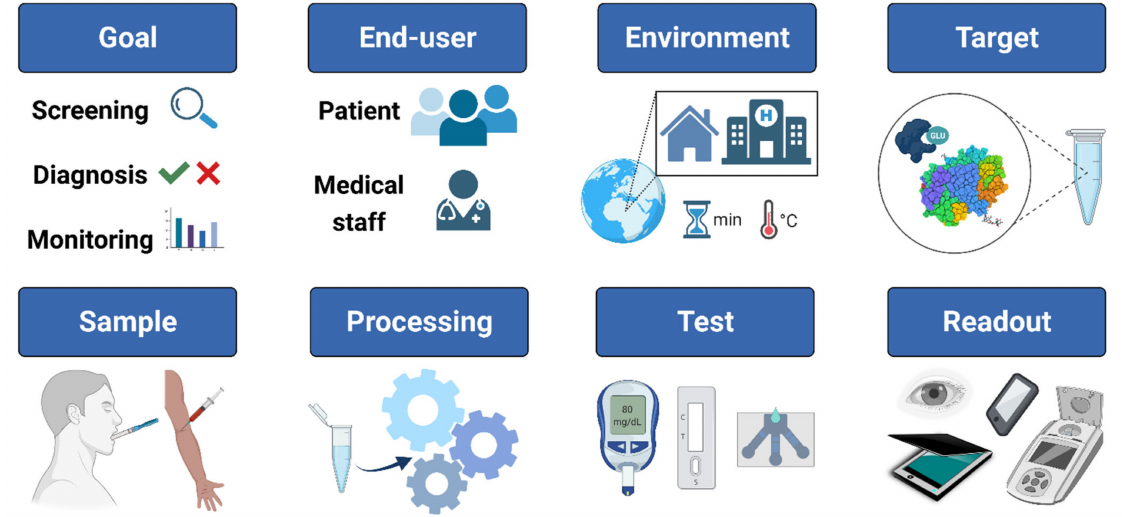
Figure 1. Principal factors involved in the design and manufacturing of point of care (POC) devices. Created with